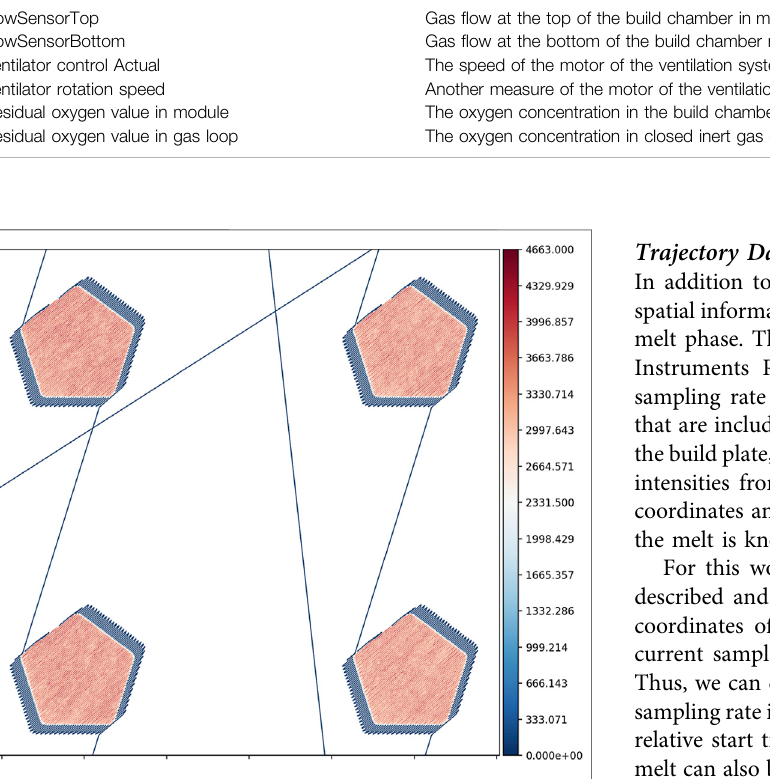
FIGURE 3 | Example of trajectory data from build 1 zoomed in on four components.Theimageshowsthemeltareas,skywriting,andjumplines,and the visualized data are the raw digital intensity levels from the on-axis photodiode that was used to determine the component boundaries for spatial